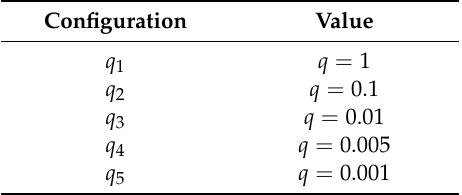
Table 5. Variations of the coe ffi cients of the characteristic